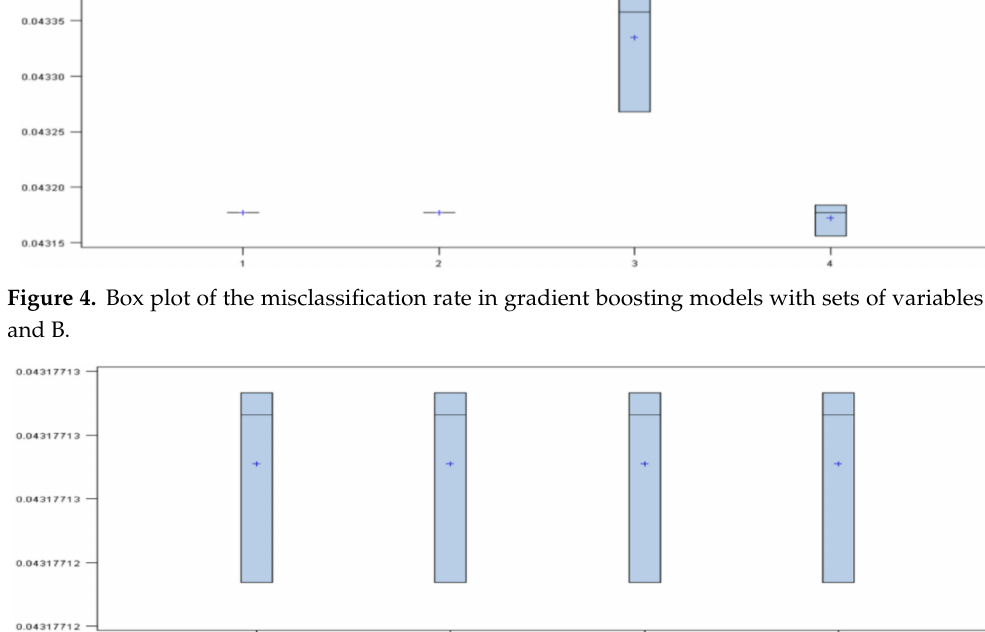
Figure 5. Box plot of the misclassification rate in gradient boosting models with sets of variables